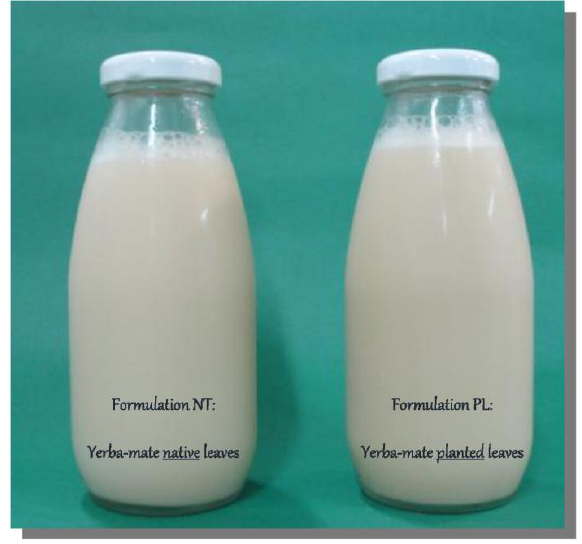
Figure 1. Aspect of the beverage of yerba-mate with soy developed in this work.